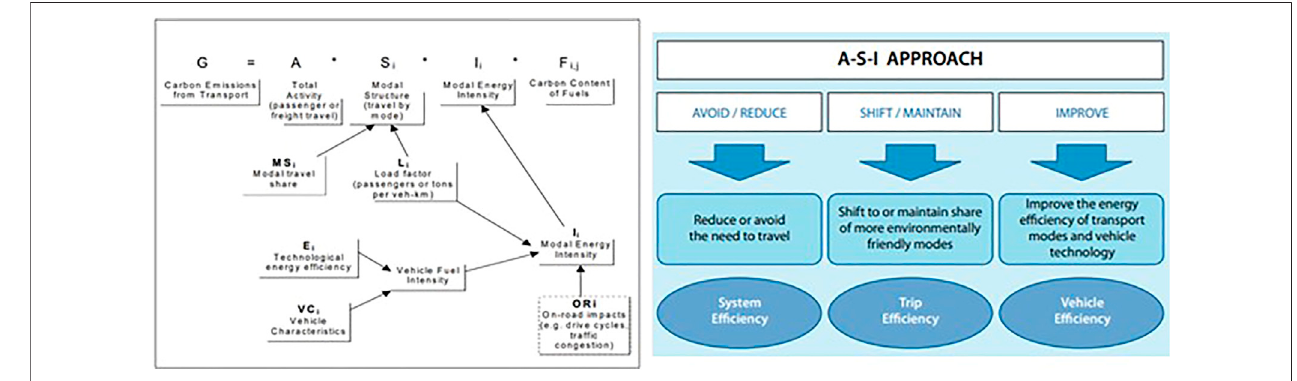
FIGURE 6 | The A-S-I-F Equation (Schipper et al., 2009) and the A-S-I Framework (Ministry of Transport, New Zealand Government,